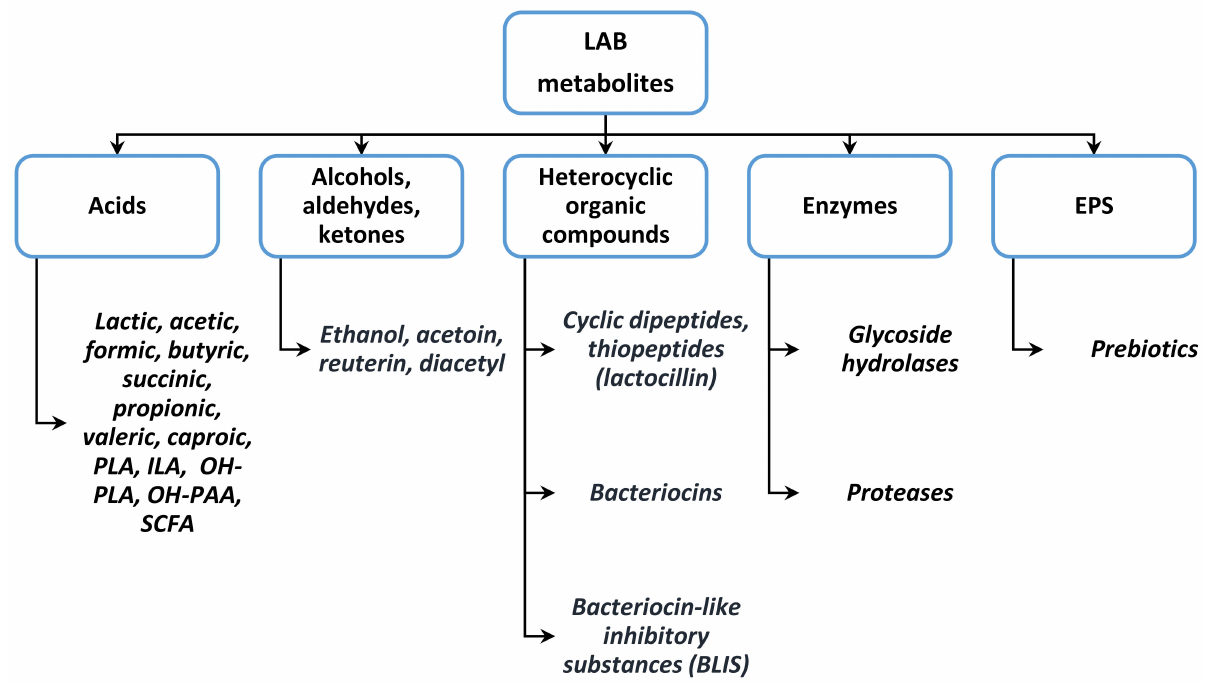
Figure 2. LAB metabolites involved in their activity against toxigenic producers. Designations: PLA, phenyllactic acid; ILA, indolelactic acid; OH-PAA, hydroxyphenylacetic acid; OH-PLA, 4-hydroxyphenyllactic acid; SCFA, branched short-chain fatty acids; EPS, exopolysaccharides. Van der Meulen et al. [30] showed that LAB also form phenyllactic, indolelactic, 4-hydroxyphenyllactic, and hydroxyphenylacetic acids, all possessing antimicrobial